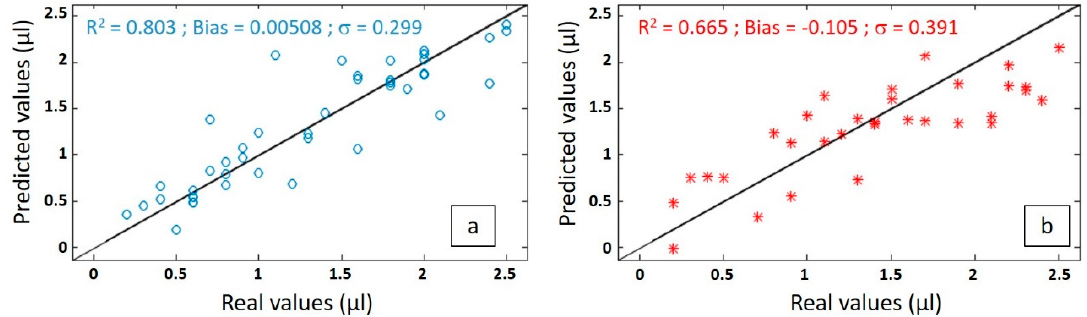
Figure 8. Model performance for the ( a ) cross-validation and ( b ) prediction.